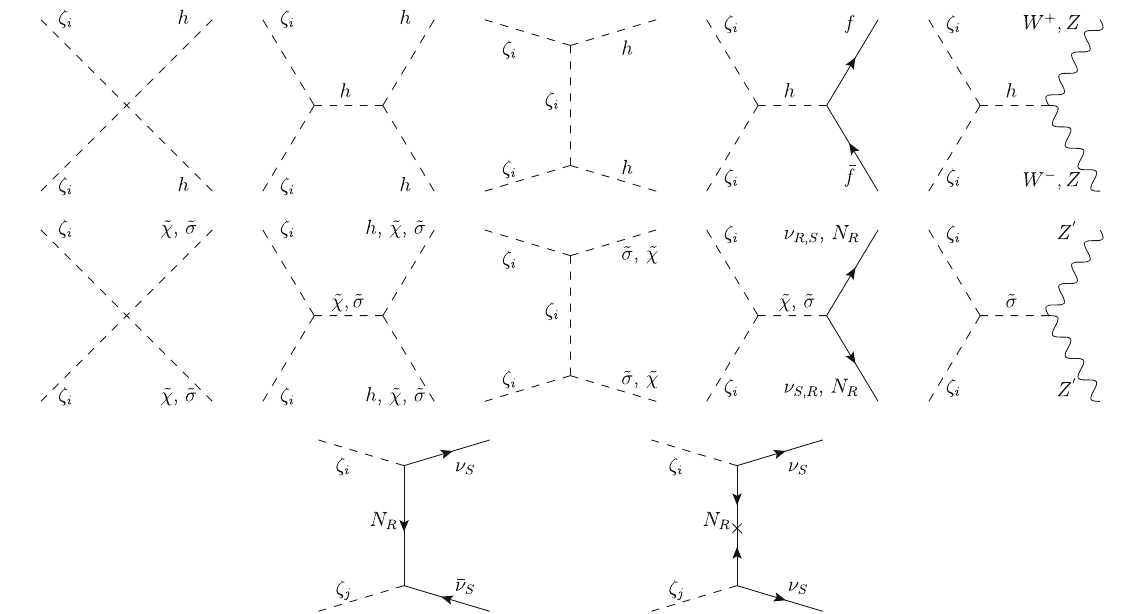
Fig. 2 Main channels contributing to the production of scalar DM ζ i , with i identifying the lightest state between the real and imaginary part of ζ , and j = R , I . Crossed diagrams are not shown, although taken into account in the analysis. f labels all the fermion fields coupled to the